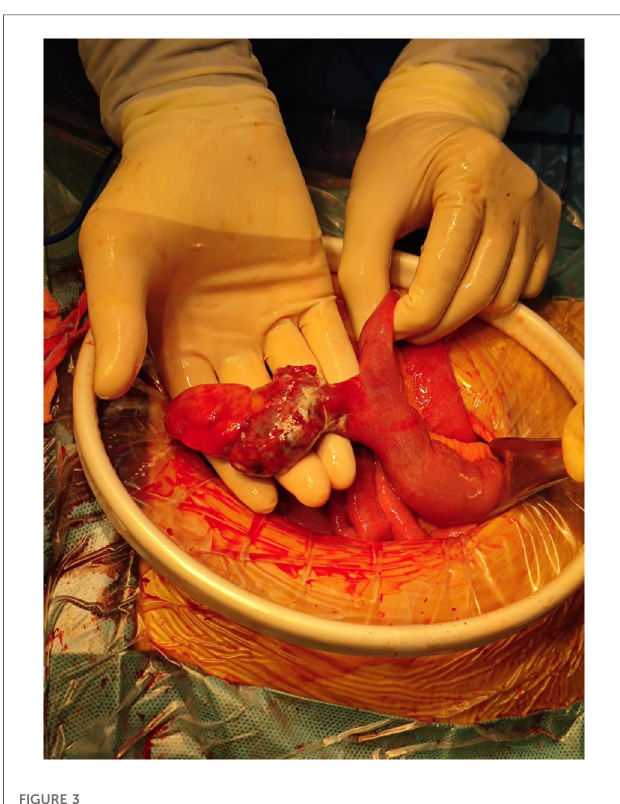
FIGURE 4 Histopathological fi ndings con fi rmed a MD.